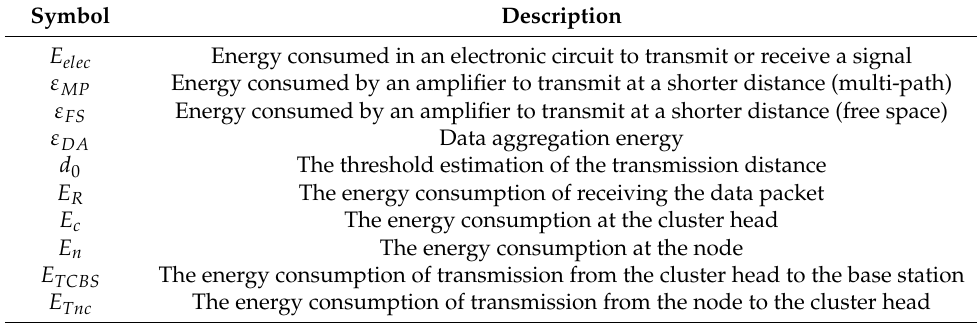
Table 1. Energy consumption radio parameters in